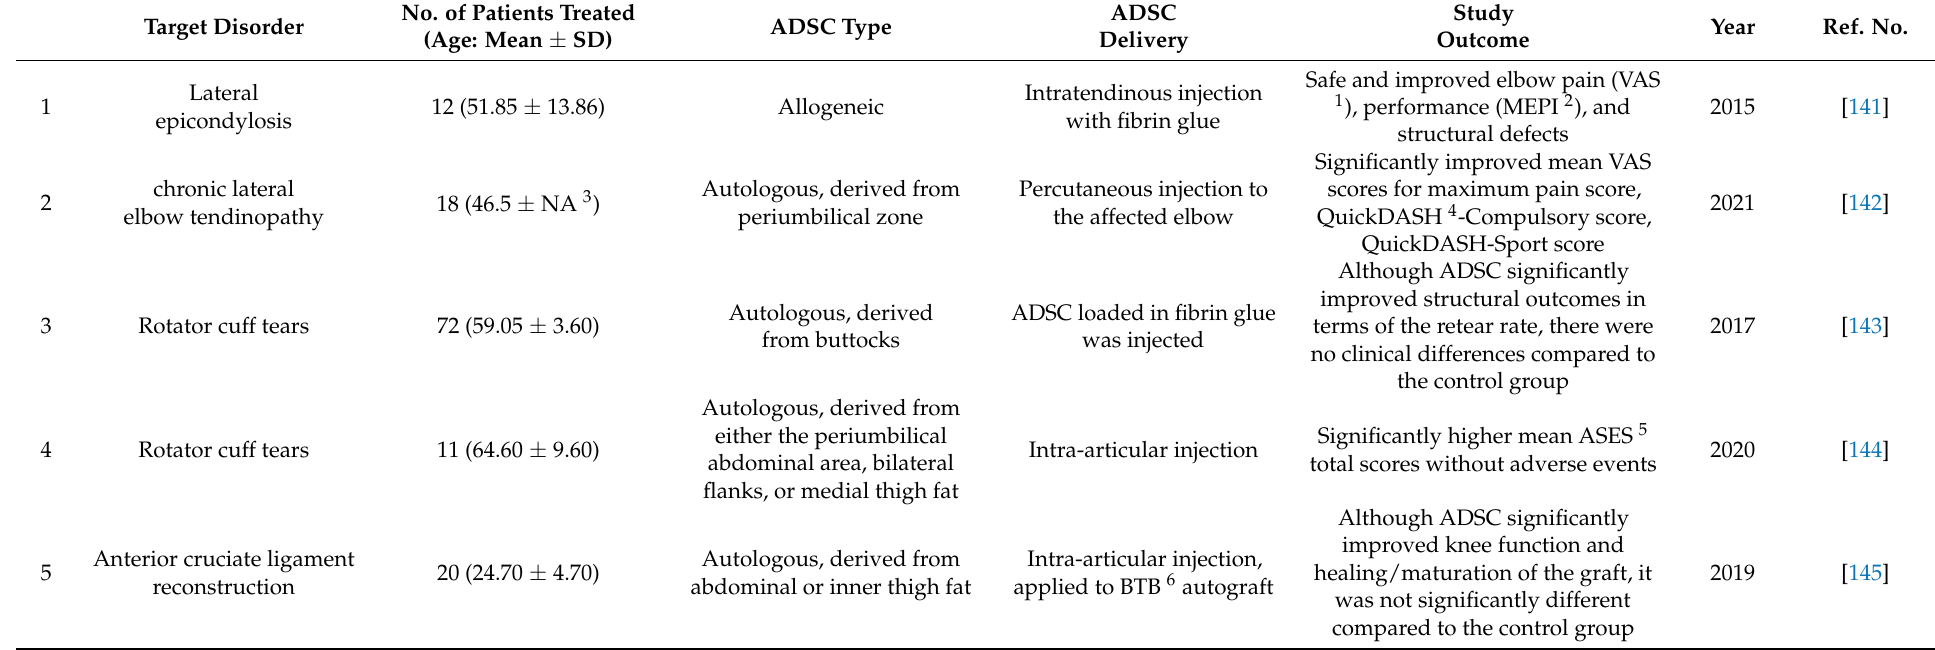
Table 3. Summary of clinical studies involving the use of isolated hADSCs on arm disorders for the last 10